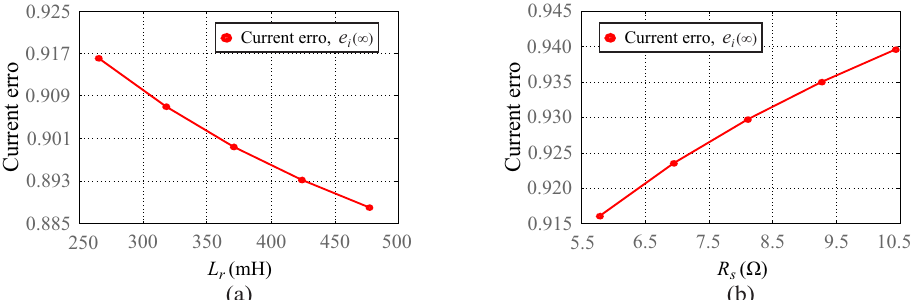
Figure 7. Armature current error values for ( a ) L r variations and ( b ) R s